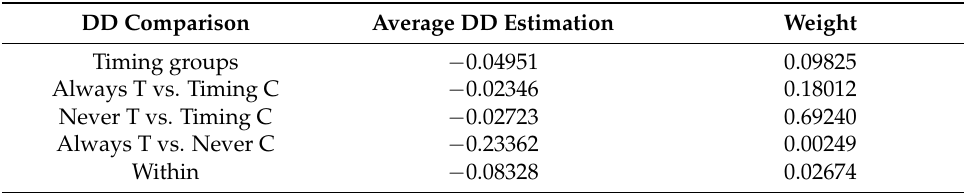
Table 6. Goodman-Bacon